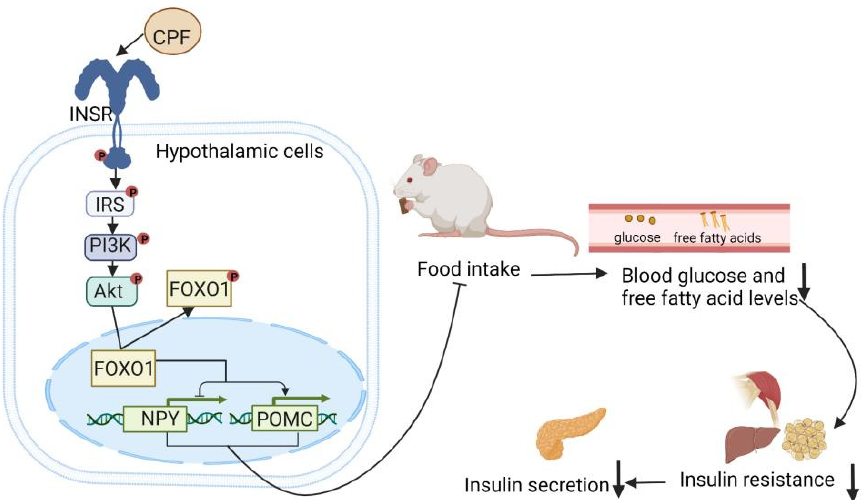
Figure 2. The mechanism of action of Cyclocarya paliurus flavonoids with respect to decreasing appetite. ↑ : increase; ↓ : decline.